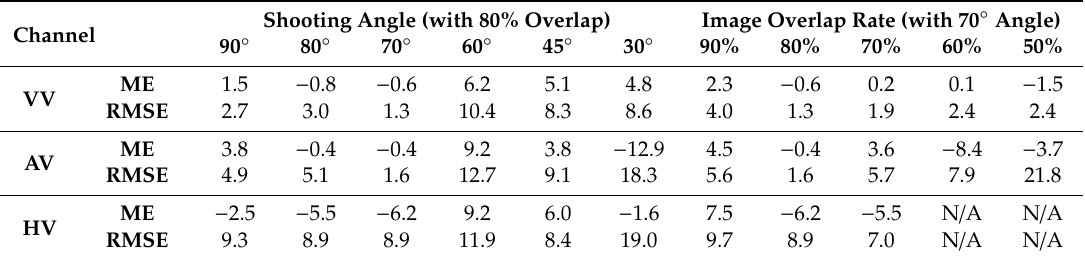
Table 4. ME and RMSE of the cross-sectional area (cm 2 ) of selected transects derived from the CGC-CRP method for V-channels on the artificial surface.